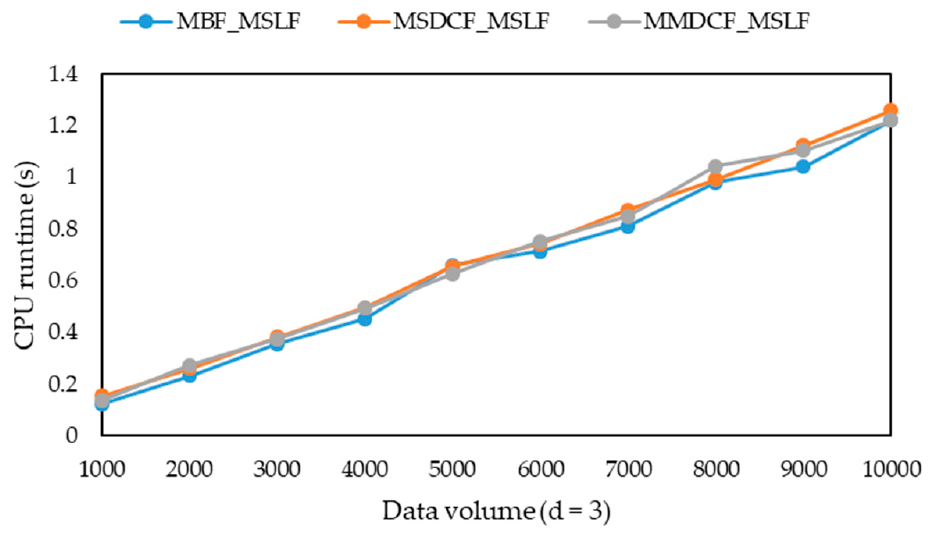
Figure 21. The CPU runtime of MBF-MSLF, MSDCF-MSLF and MMDCF-MSLF with different data volumes ( d = 3).